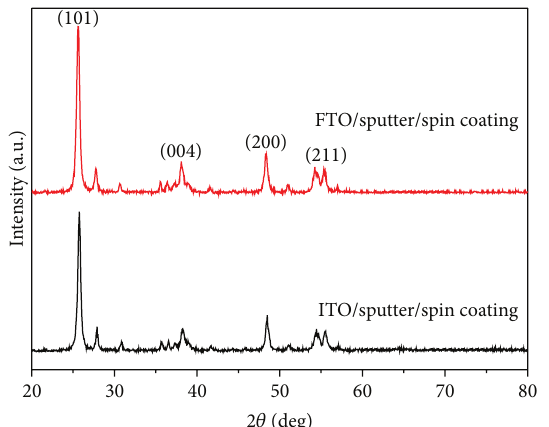
Figure 10: The XRD patterns for the TiO 2 films, annealed at 450 ∘ C.